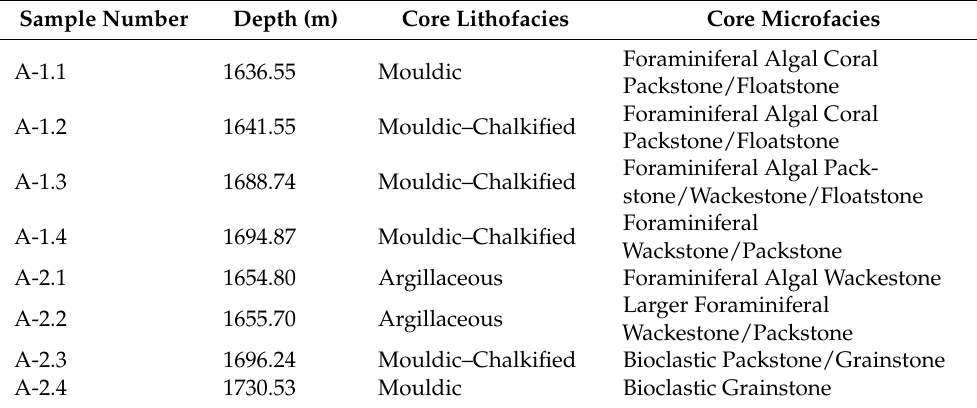
Table 2. Lithosfacies and microfacies of PETRONS-1 and PETRONS-2 core samples.